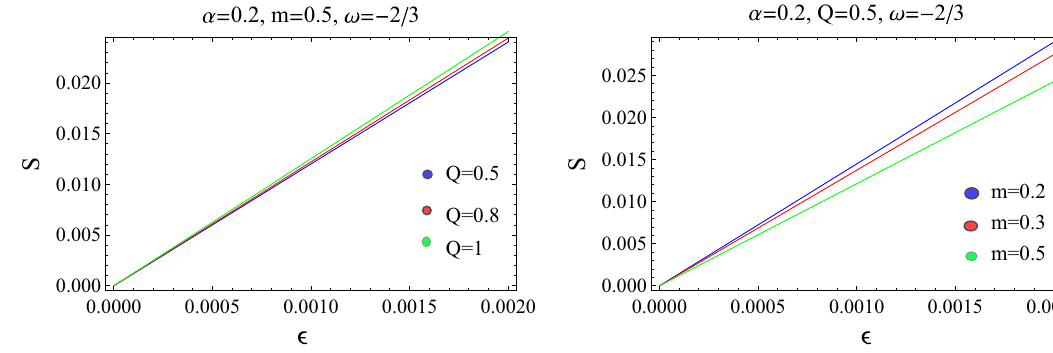
Fig. 8 Behavior of entropy versus thickness of the shell with β = 0 . 5 and b 0 = 1